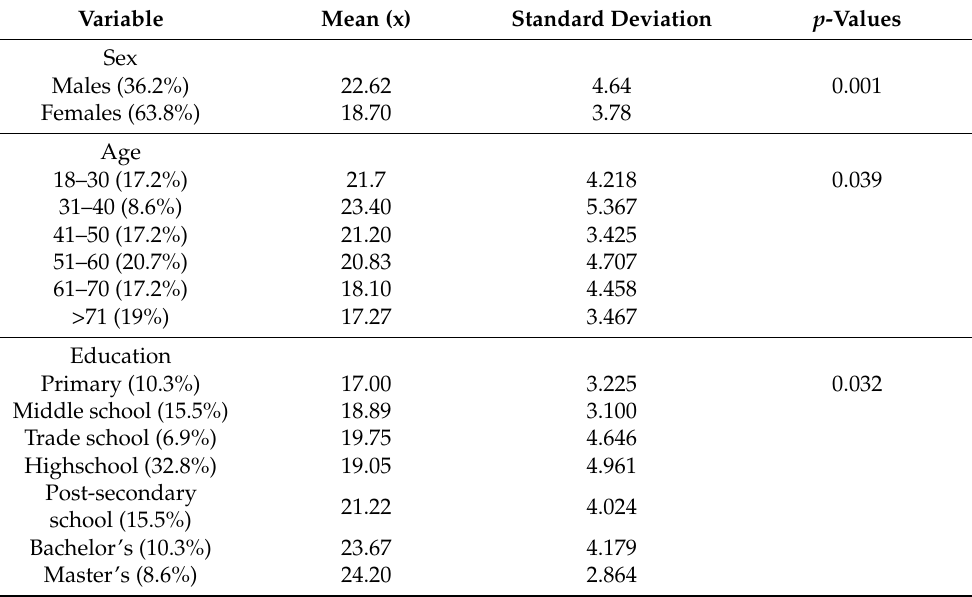
Table 1. Mean scores and standard deviation for the self-medication scale for different demo- graphic groups.